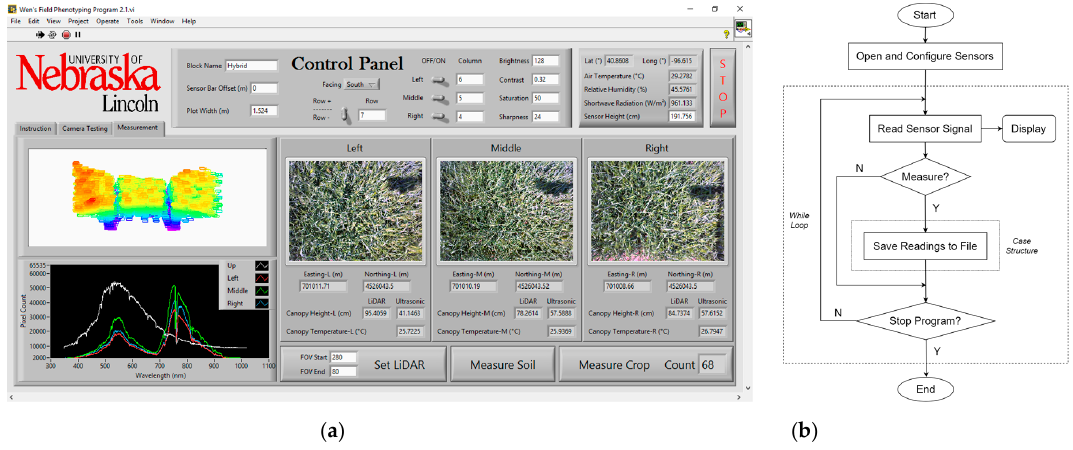
Figure 3. Customized LabVIEW program: ( a ) front panel; ( b ) flowchart of block diagram.